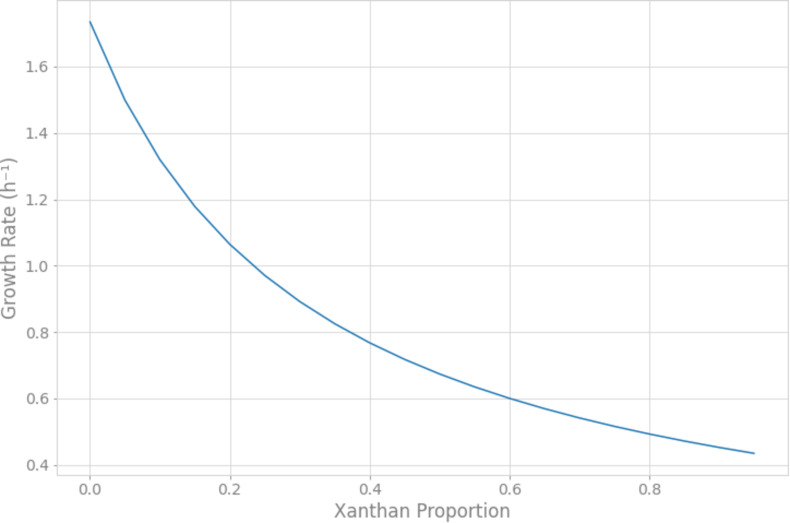
Trade-off between xanthan production and growth rate. The simulation of the response of the growth rate to the change in the xanthan proportion to biomass was performed through flux balance analysis. The xanthan proportion corresponds to the stoichiometric coefficient defined in the alternative objective function for xanthan metabolite. The growth rate decreases when xanthan production increases. The growth rate does not go down to zero because xanthan is part of the biomass function.